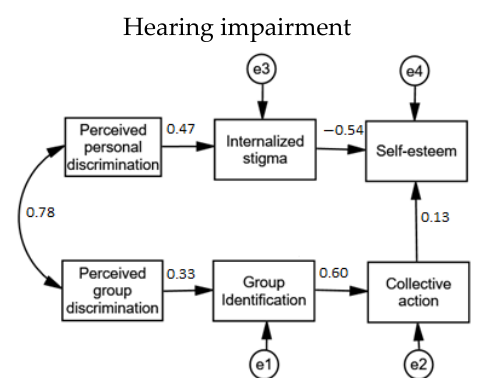
Figure 2. Multigroup model.